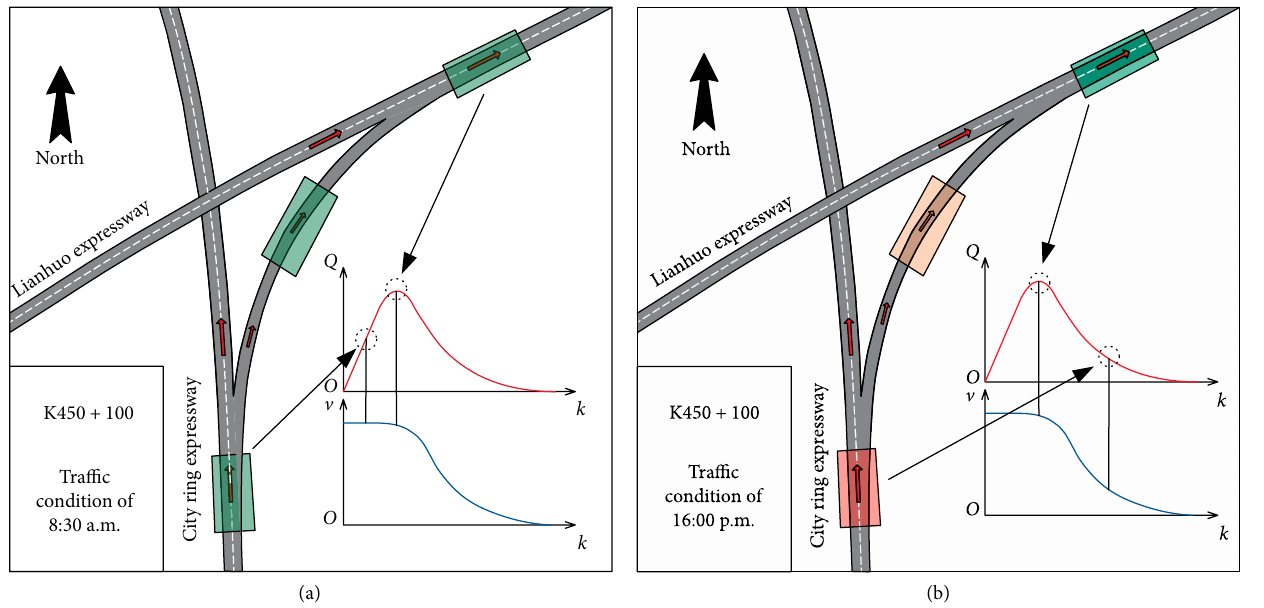
Figure 1: The phenomenon observed on Baqiao interchange. (The red arrow depicts moving directions of the vehicles, green rectangles depict free flow in certain sections, red rectangle depicts congested flow, and orange rectangle depicts the increase of traffic volume in on-ramp). (a) Traffic condition in Baqiao interchange at 8:30 a.m. (b) Traffic condition in Baqiao interchange at 16:00